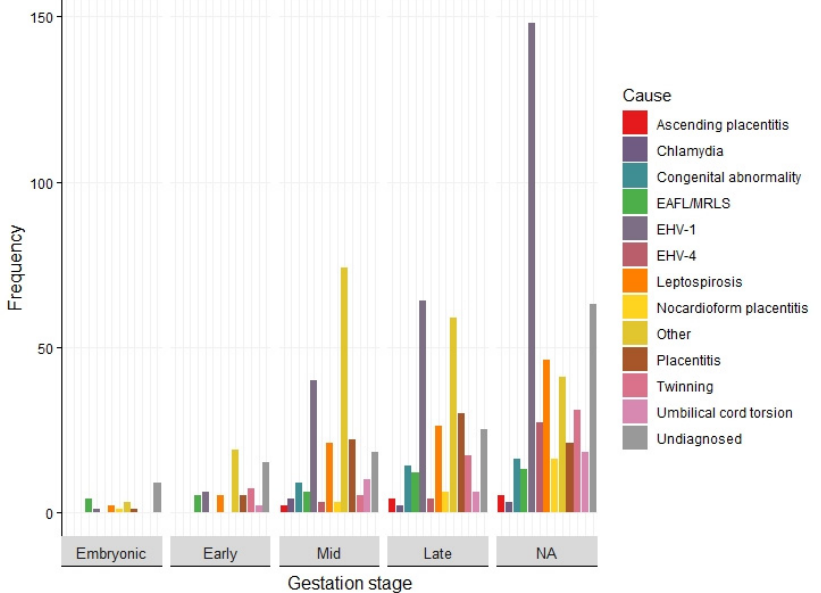
Figure 5. Causes and syndromes associated with equine pregnancy loss by stage of gestation collected from 514 studies captured in a scoping review of the reported causes and syndromes associated with mid to late-term pregnancy loss in horses globally. NA indicates records which did not provide data on the stage of gestation. Seventy-five different breeds of horses were reported in the scoping review. Two hundred and eleven records contained information on Thoroughbreds (41%), with 128 in records included Standardbreds ( n = 49), Quarter horses ( n = 44) and Arabian horses ( n